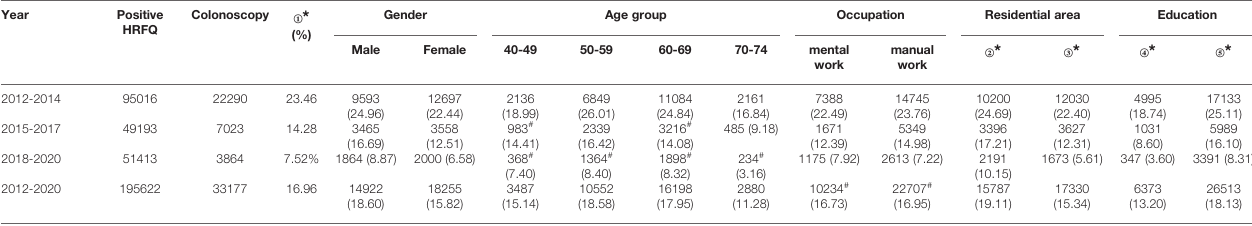
TABLE 7 | Analysis of compliance results of subsequent colonoscopy in positive HRFQ participants, (n,%). Year Positive Colonoscopy ① * HRFQ (%)